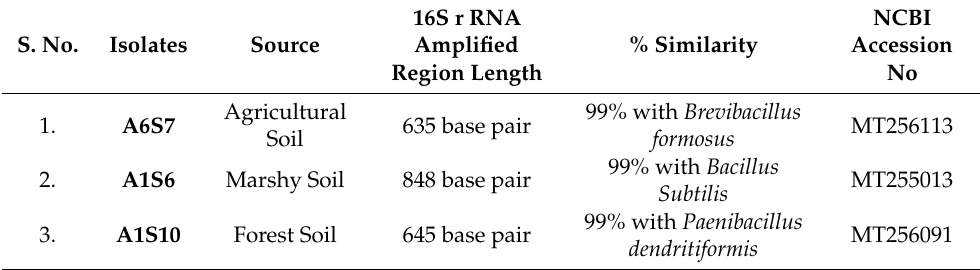
Table 8. Identification of bacterial species based on sequences